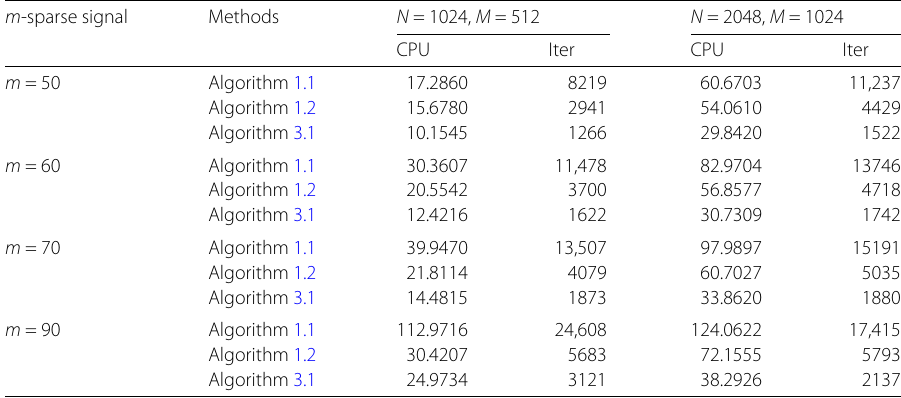
Table 1 Computational results for compressive sensing m -sparse